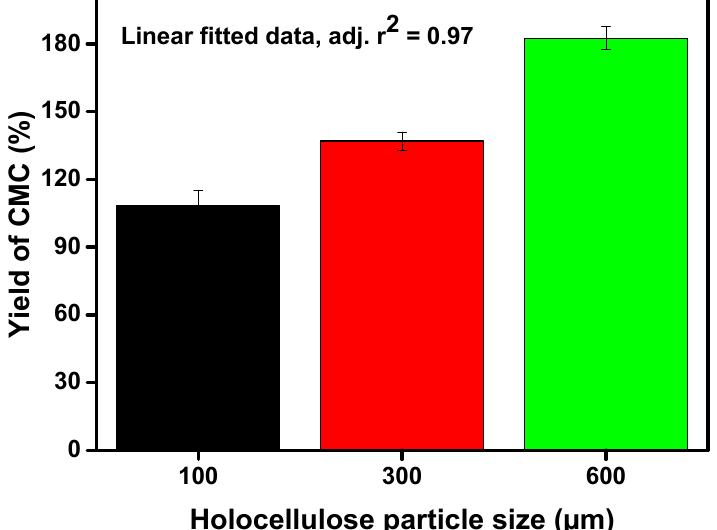
Figure 2. Degree of substitution of the synthesized CMC depending on varying particle size of holocellulose.